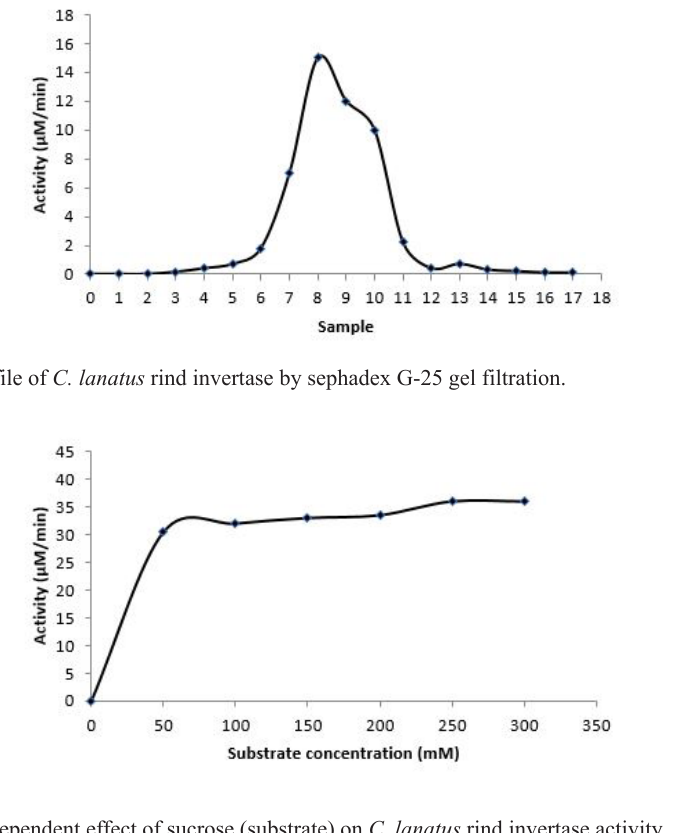
Determination of optimum temperature The graphical representation of the effect of temperature on the activity of C. lanatus rind invertase is shown in Figure 5. The peak activity of the enzyme was observed at 50 ºC, with gradual decline in activity as the temperature was increased